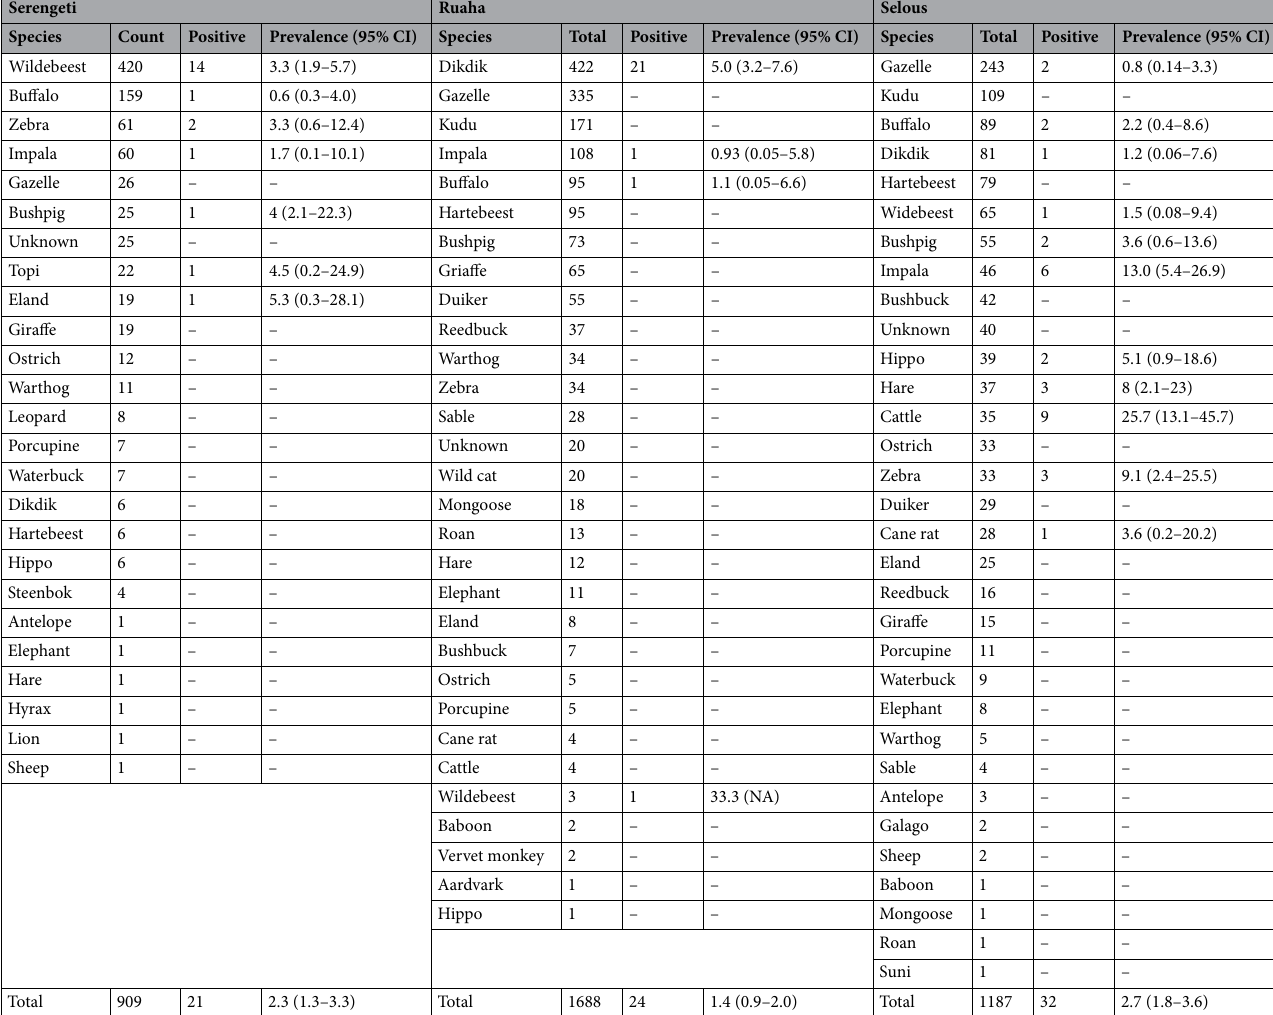
Table 1. Wildlife species distribution, counts, and prevalence of pathogens in each regions of Serengeti, Ruaha, and Selous. "–": no data; NA: result not reliable and not